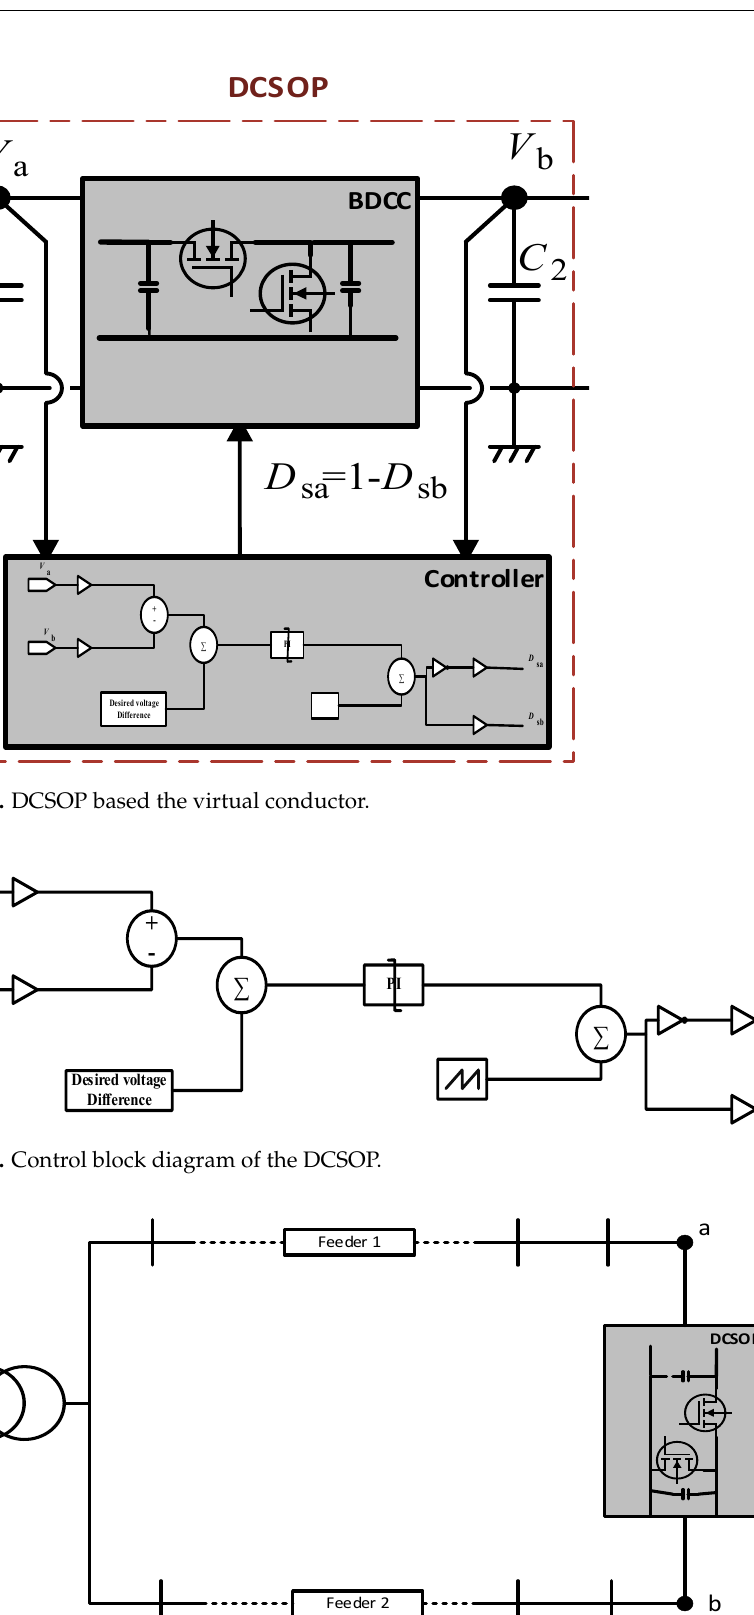
Figure 3. Basic configuration of a distribution network with a DCSOP.